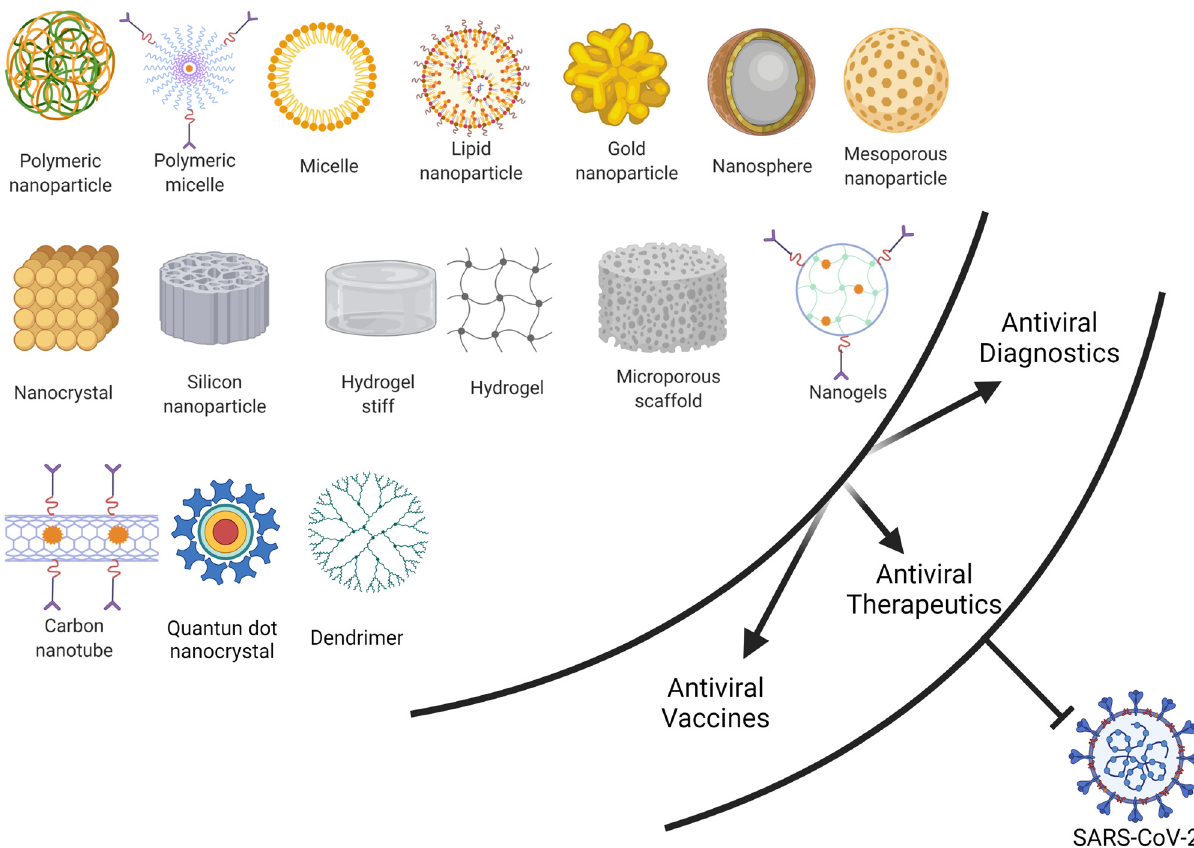
Figure 2: Nano - sized materials utilized in diagnosing, fi ghting, and preventing COVID -